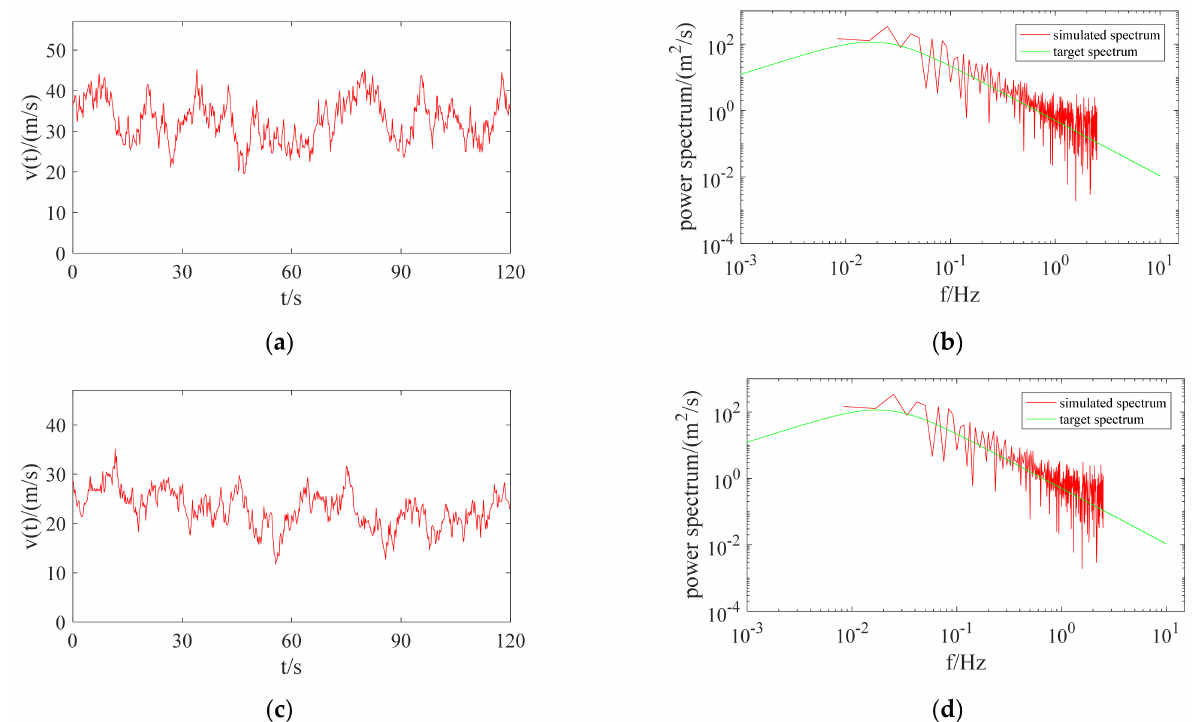
Figure 14. Time-history and power spectrum curves of fluctuating wind. ( a ) Time-history curve of wind speed at the highest point, ( b ) power spectrum curve at the highest point, ( c ) time-history curve of wind speed at the lowest point, ( d ) power spectrum curve at the lowest